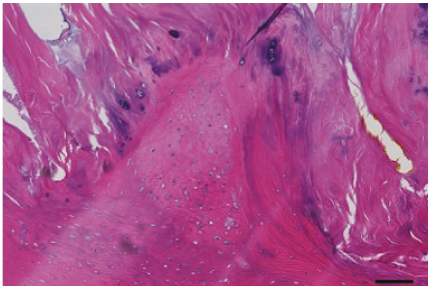
Figure 6: Microphotograph of the resected heterotopic ossi fi cation. Lamellar bone formation with an extensive cartilage metaplasia partly with mixed tissue of fat and necrotic muscle. Calci fi cation and cartilage metaplasia existed in the transitional zone between the ossi fi cation and the remaining tendon, that is, endochondral ossi fi cation. Scale bar, 100 μ